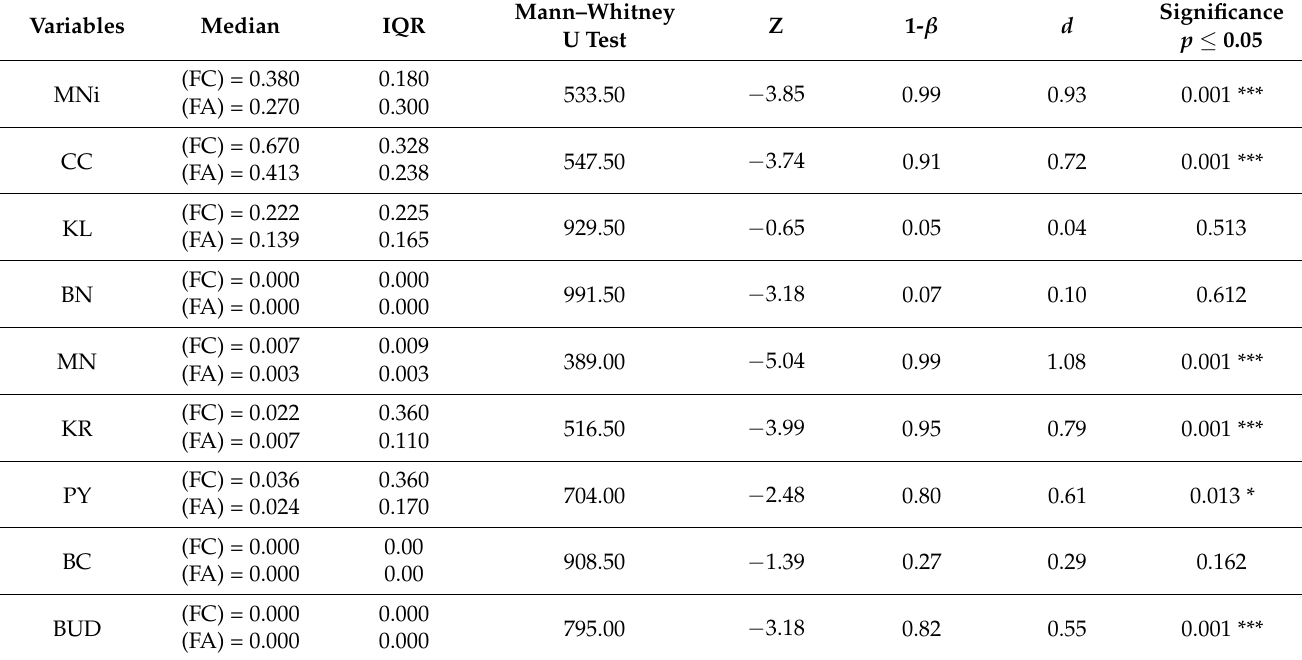
Table 4. Comparison of BMCA results between exposed (FC) and control (FA)